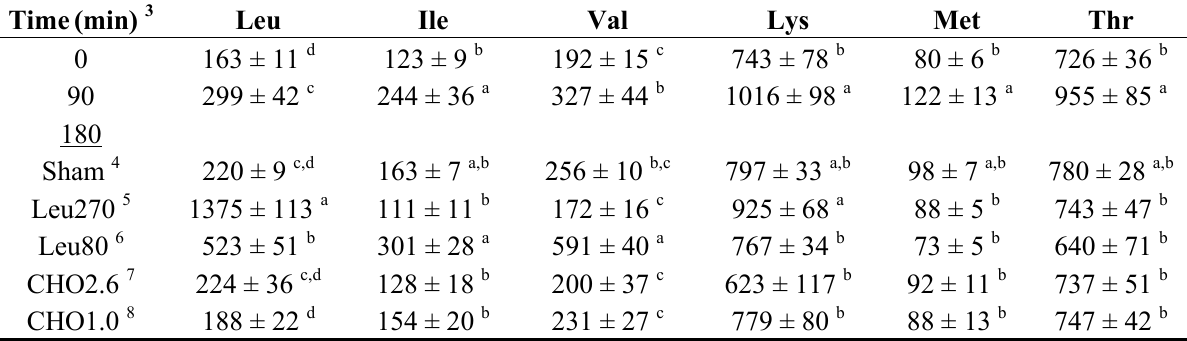
Table 3. Post-meal plasma amino acid responses for Experiment 1 1,2